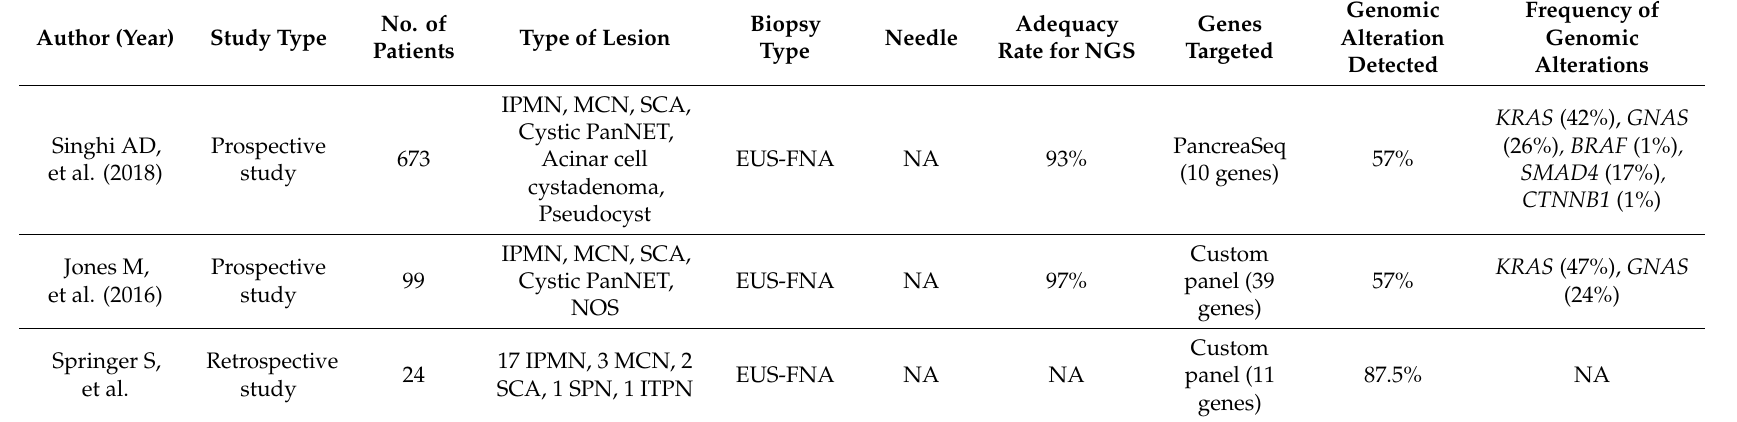
Table 2. Summary of studies evaluating NGS using EUS-TA samples in pancreatic cystic